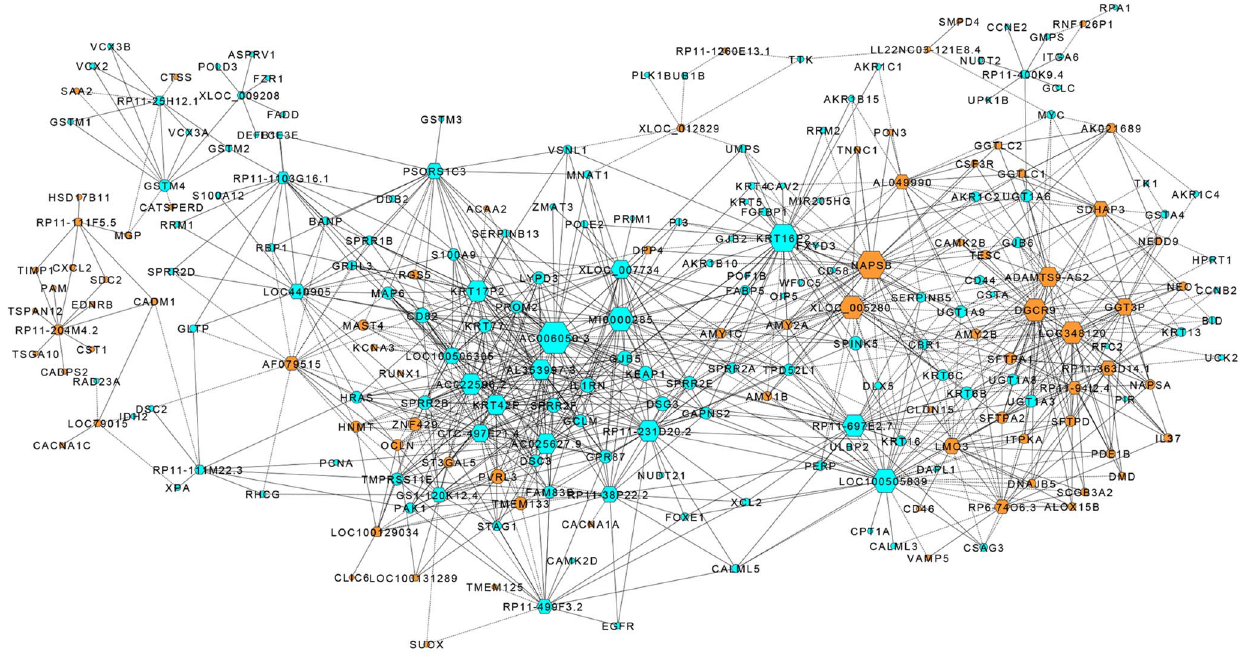
Figure 4. LncRNA-mRNA-network was constructed based on the correlation analysis between the differential expressed lncRNAs and mRNAs. In the network, a regular hexagon node represents lncRNA, circular node represents the mRNA. A brown node represents an upregulated lncRNA or mRNA and a blue node represents a downregulated lncRNA or mRNA.